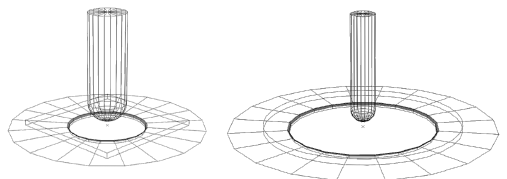
Figure 1. Striker and support ring geometries ISO (left) and ASTM